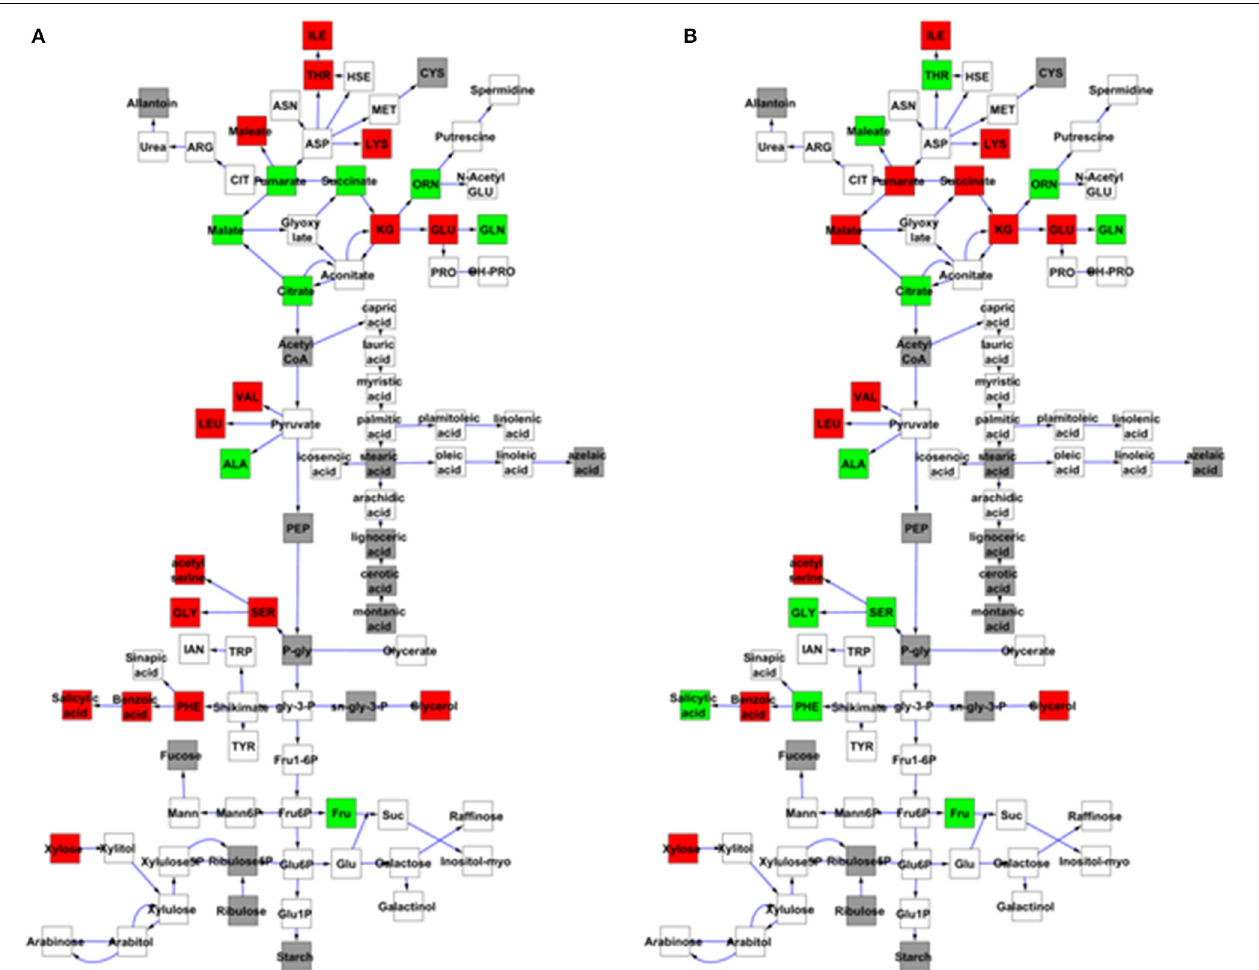
FIGURE 6 | Quantitative complementation to validate MNM1 as the Met.V.67 QTL. Full genomic Bay or Sha alleles of MNM1 were transgenically reintroduced into both the mnm1-1 and mnm1-2 background genotypes. Homozygous T2 lines were analyzed for metabolomics at either 4 or 24h in a free-run experiment as identified as key timepoints for MNM1 function. The 4h timepoint is the same that was sampled to identify the Met.V.67 QTL. The effect on only central metabolites showing a significant difference between the Bay and Sha allele when introduced into both the mnm1-1/2 genotypes presented at the specific timepoint shown. The gray boxes show metabolites not measured in these experiments, white boxes are metabolites that had no